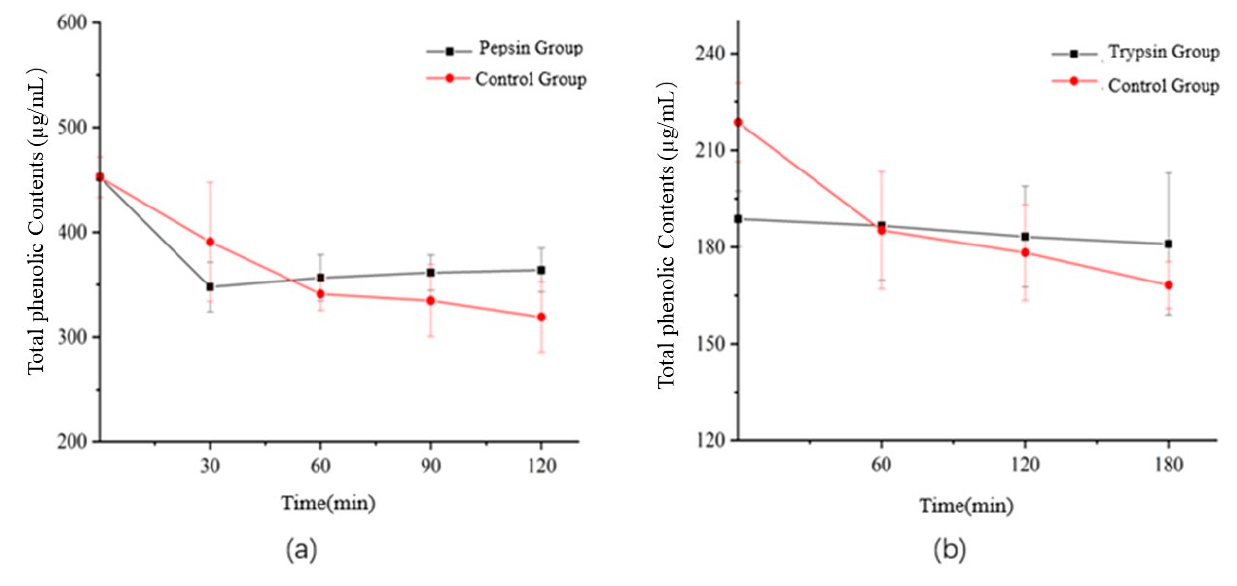
Figure 6. Changes of total flavonoids in simulated gastric ( a ) and intestinal ( b ) digestion of Semen Hoveniae in vitro.